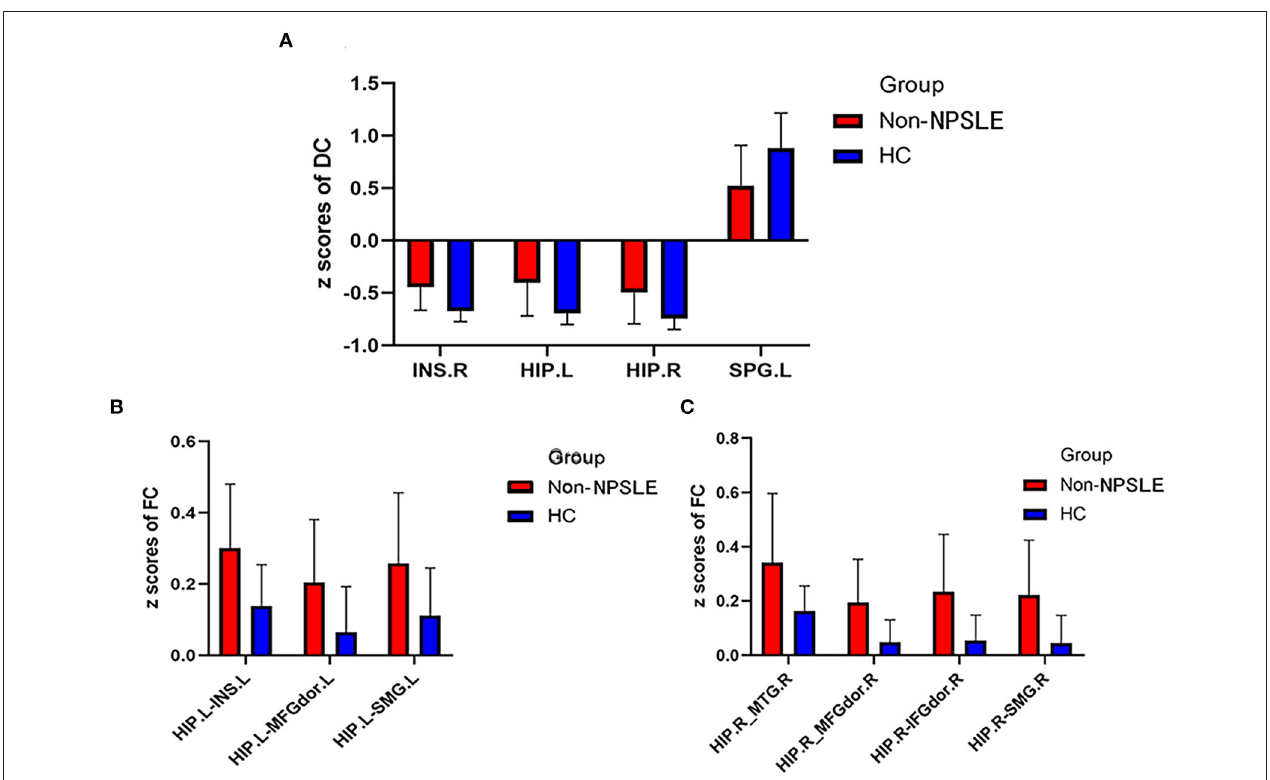
FIGURE 3 | Comparison of DC z scores and FC z scores between two groups (DC, Degree centrality; FC, Functional connectivity; Non-NPSLE, Non-neuropsychiatric systemic lupus erythematosus; HC, Healthy control; INS.R, Right insula; HIP.L, Left hippocampus; HIP.R, Right hippocampus; SPG. L, Left superior parietal gyrus; INS.L, Left insula; MFGdor.L, Left dorsolateral middle frontal gyrus; SMG.L, Left supramarginal gyrus; MTG.R, Right middle temporal gyrus; MFGdor.R, Right dorsolateral middle frontal gyrus; IFGdor.R, Right dorsolateral inferior frontal gyrus; SMG.R, Right supramarginal gyrus). (A) DC z scores of non-NPSLE vs. HC. (B) FC